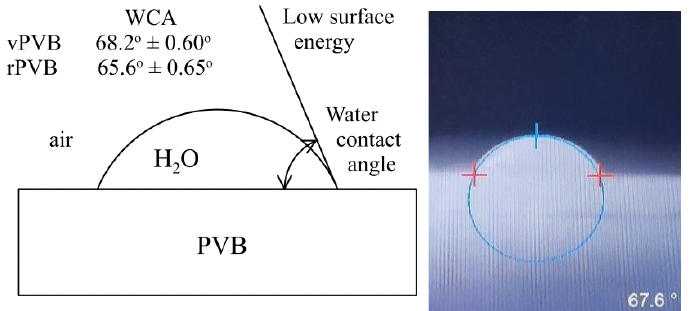
Figure 15. Water contact angle measurements (mean ± standard deviation) for vPVB and rPVB.